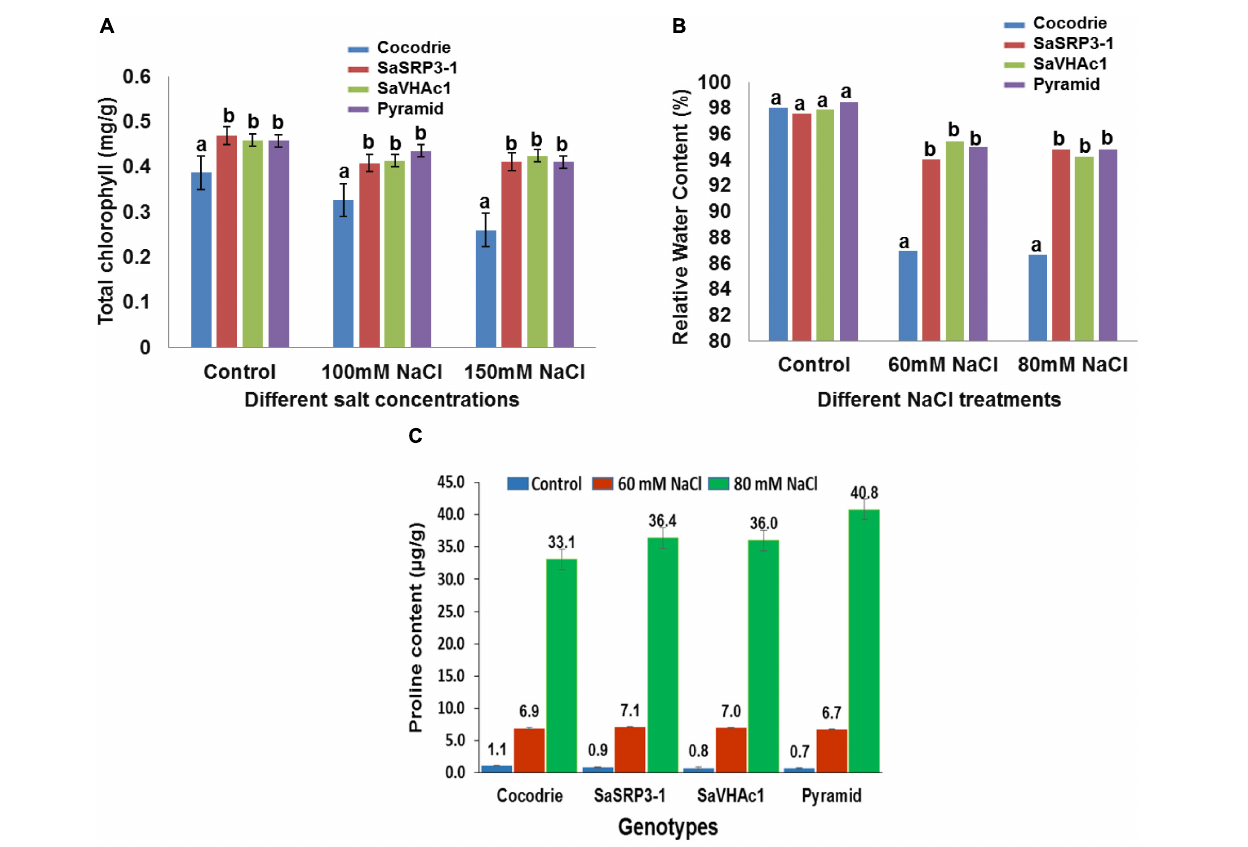
FIGURE 6 | Physiological analysis of Cocodrie, single gene ( SaSRP3-1 and SaVHAc1) and pyramided transgenic rice plants. (A) Total chlorophyll content in leaf samples from different transgenic and Cocodrie (WT) plants 4 days after salt stress (100 and 150 mM NaCl); (B) Comparison of relative water content (RWC) under control and salt stress (60 and 80 mM NaCl) conditions; (C) Proline accumulation in transgenic and WT plants under salt stress (60 and 80 mM NaCl) 10 days after salt stress. Error bars represent standard error. Different letters on bar diagram indicates statistical significance at 5% level based on Dunnett’s